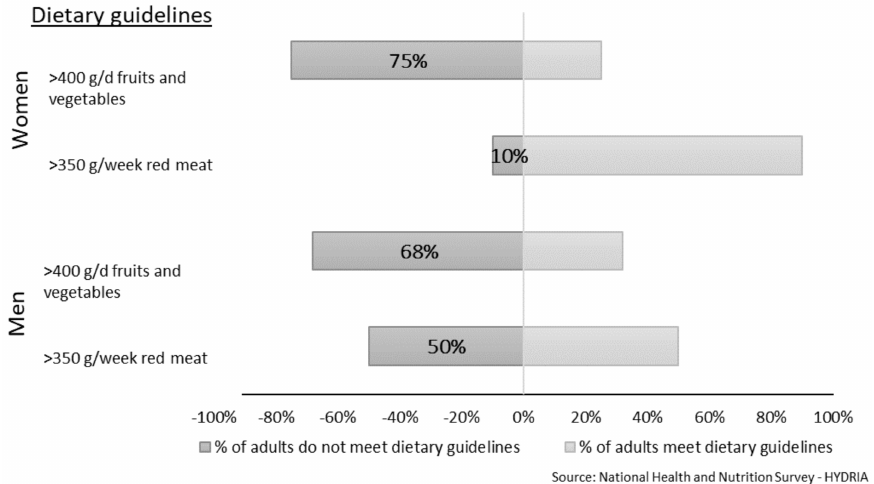
Figure 1. The percentage of adults meeting food dietary recommendations based on WHO and AICR/WRCF guidelines for fruits and vegetables (g/day) and red meat (g/week) in the Greek National Health and Nutrition